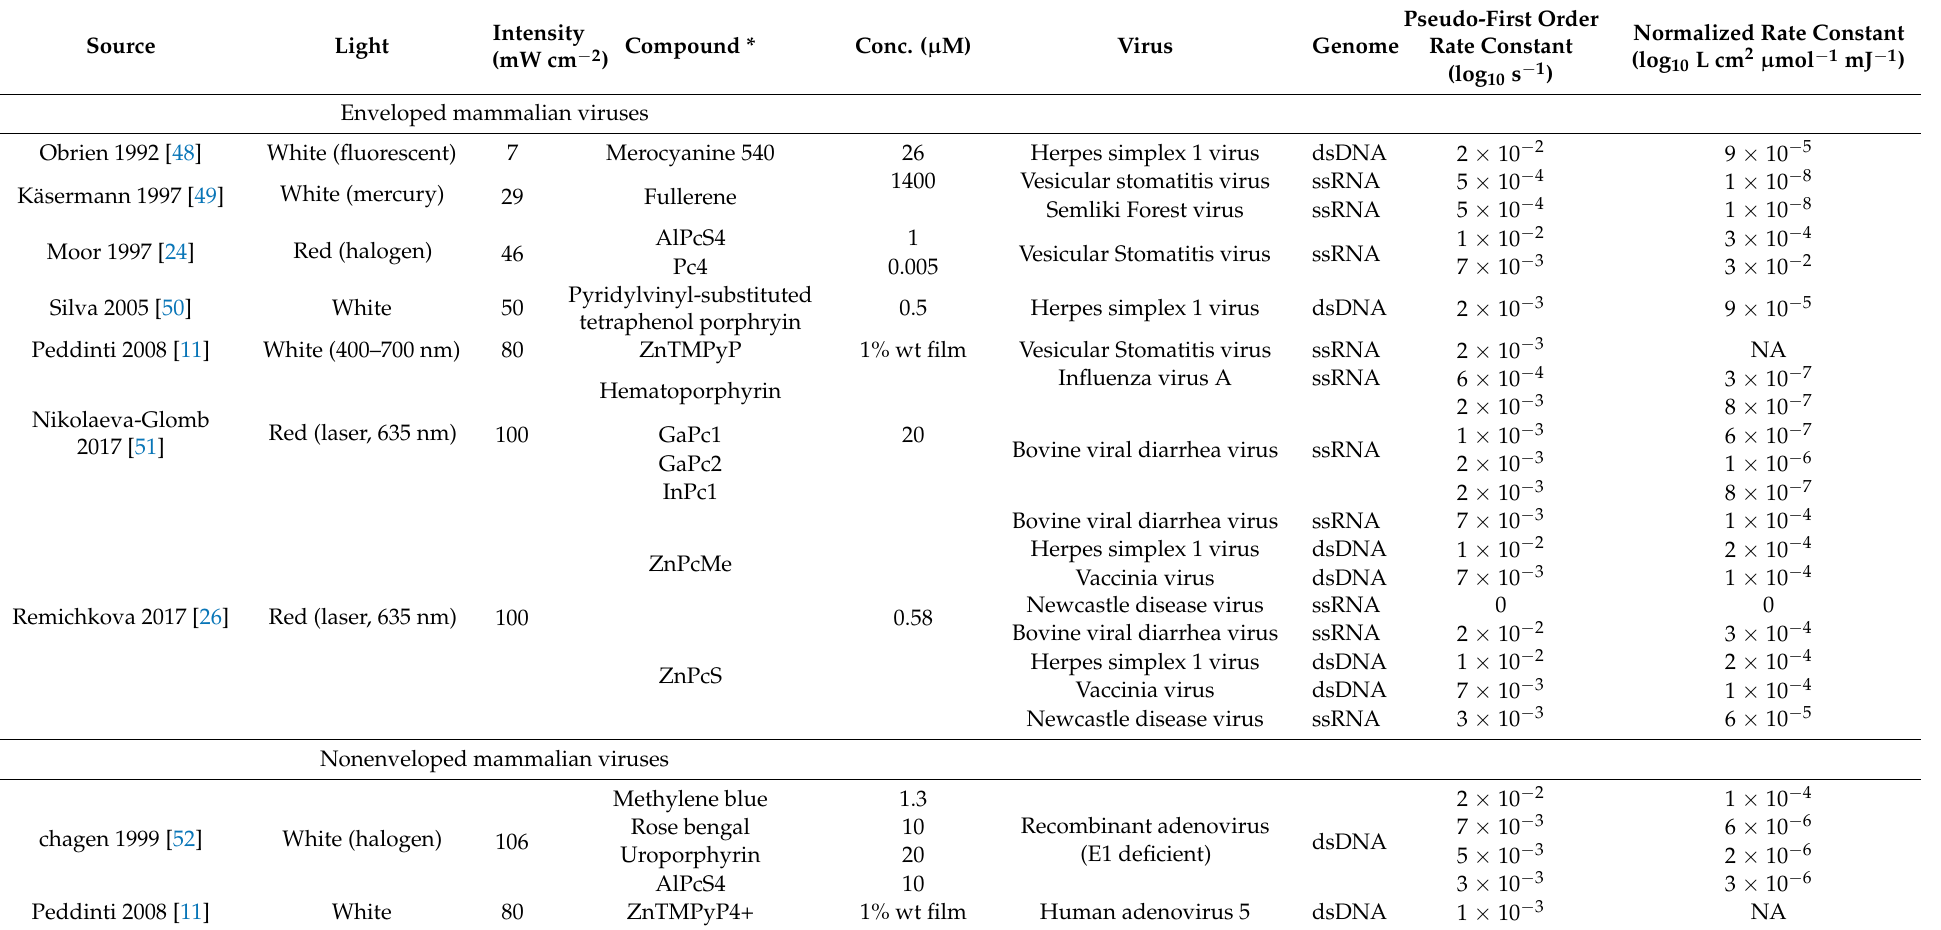
Table 2. Comparison of visible light photodynamic virus inactivation across this and other